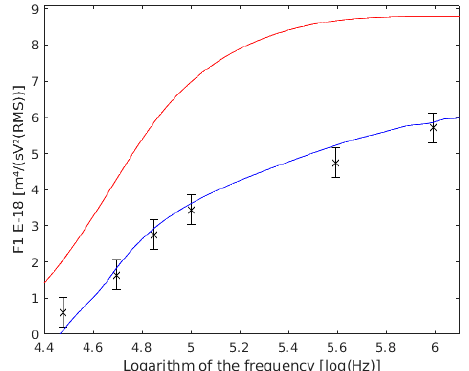
Figure 12. Comparison between our experimental data of F 1 for double cells and the values obtained by Asami (1996) [56] and Hölzel (1992) [57] models. F 1 with the data of Holzel are shown in red, the data of Asami are shown in blue, and the results of this work are the six points with their confidence intervals drawn.